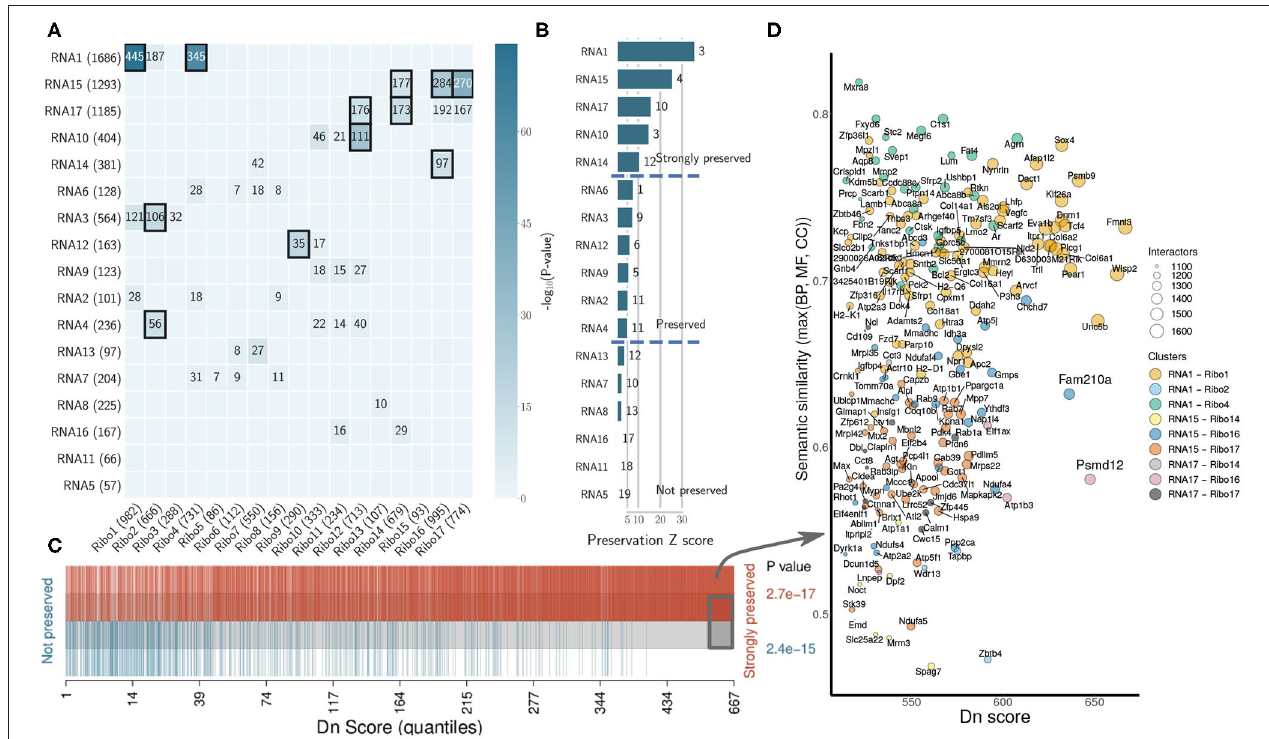
FIGURE 4 | The organization of the heart transcriptome and translatome under cardiac remodeling. (A) Cross-tabulation of RNA -seq (rows) and Ribo-seq (columns) modules. Each row and column is labeled by the corresponding module and its size (number of genes). Counts of genes in the intersection is shown for modules sharing a significant overlap ( p < 0.01, two-tailed Fisher’s exact test). Overlap with p < 1e-10 are highlighted. (B) Preservation Z scores (mean of Z -scores computed for density and connectivity measures) for the RNA -seq modules in the Ribo-seq network. The vertical lines indicate the threshold for moderate preservation (5) and strong preservation (10). The medianRank statistic is indicated to the right of each bar. (C) Barcode plot showing the enrichment of genes based on their dynamic neighborhoods score (Dn score), compared to their association with modules that are either strongly or not preserved. Genes are ranked according to their Dn score, and colored based on their association. The gray box toward the right indicates genes for which Dn score is greater than two standard deviations above the average. To test whether genes belonging to preserved or not preserved clusters are highly ranked in terms of Dn score, the camera test from the limma R package was performed and p -values are shown. (D) Scatter plot of the most rewired genes (gray box in C ). A semantic similarity analysis was performed for each ontology (BP, MF, and CC) and every gene using its immediate interactors in the RNA -seq and Ribo-seq networks, respectively, and the maximum semantic similarity is reported on the y-axis. The set of all translated genes was used as background. Dots are colored according to their cluster association, and the size represents the total number of interactors, or connected genes, in a hypothetical joint network combining the respective RNA -seq and Ribo-seq modules. Semantic similarity was calculated using the GOSemSim R package. Only genes in modules with significant overlap are reported. BP, Biological Process; MF, Molecular Function; CC, Cellular